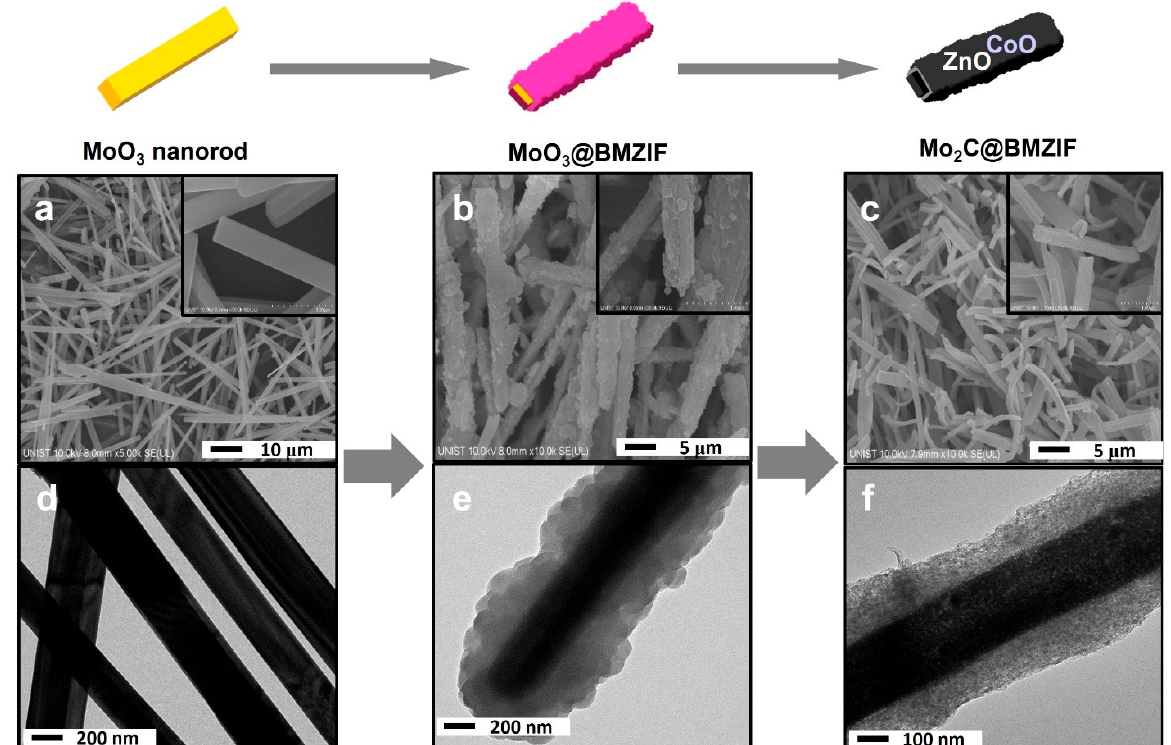
Figure 1. Structural change in ZIF-decorated Mo carbide nanorods. ( a – c ) FE-SEM and ( d – f ) TEM images of ( a , d ) as-prepared MoO 3 nanorods, ( b , e ) MoO 3 @BMZIF composite, and ( c , f ) Mo 2 C@BMZIF-700 °C (4 h) core@shell structure after carbonization under an N 2 atmosphere at 700 °C for 4 h. MoO 3 @BMZIF to Mo 2 C@BMZIF. As-synthesized MoO 3 nanorods showed a typical